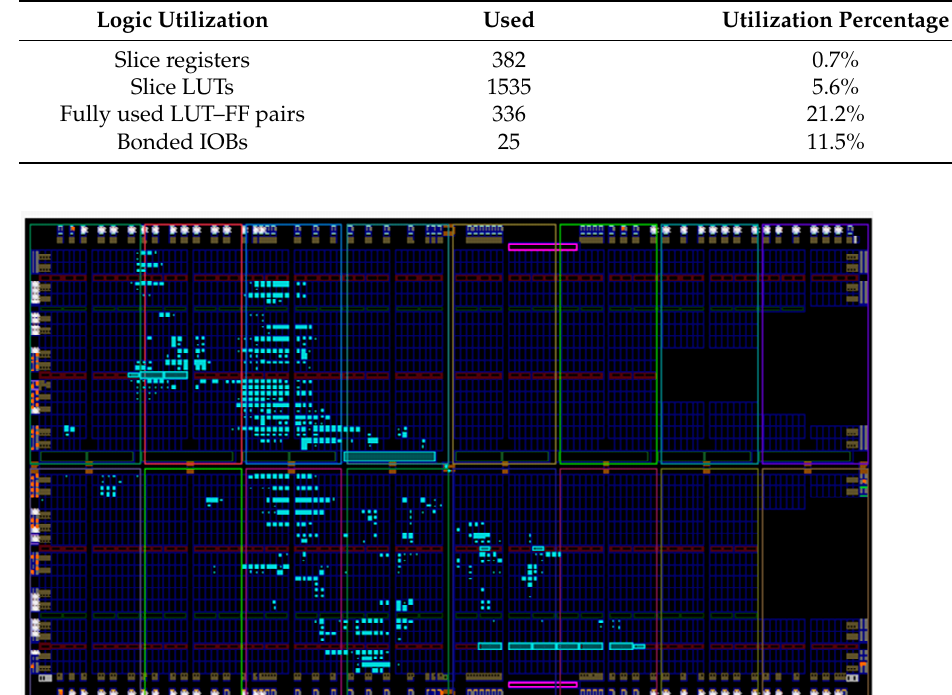
Figure 14. Place and route (PnR) result in